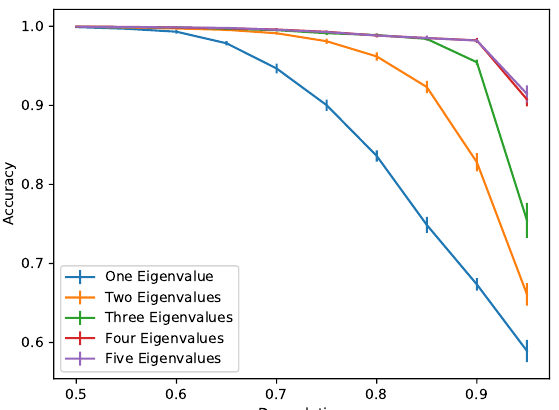
Figure 9. Comparison of the performance using different numbers of natural modes for different levels of damage.